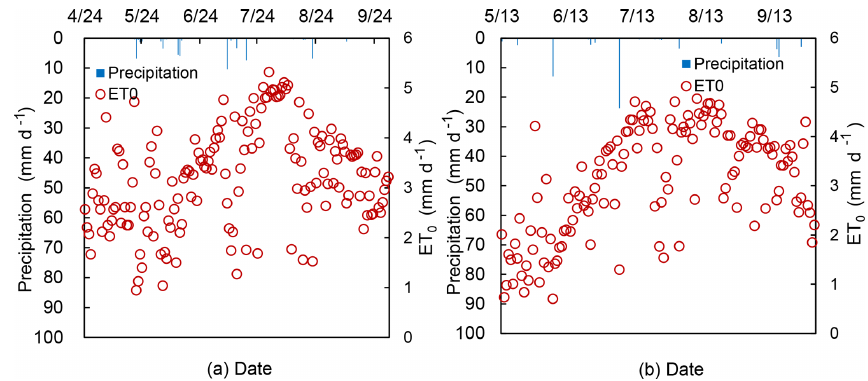
Figure 2. Daily reference evapotranspiration, ET 0 , and precipitation during the growing season in (a) 2016 and (b) 2017. Table 3. Soil physical properties of the Fenzidi experimental